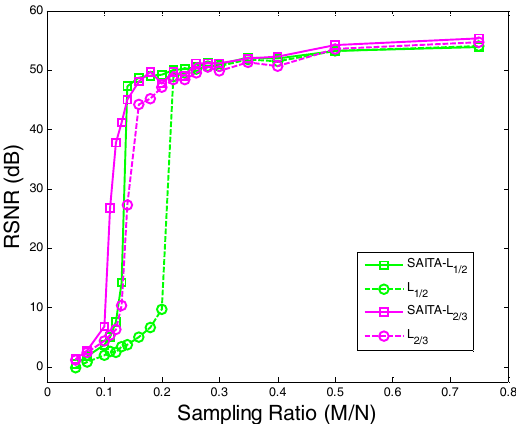
Figure 11. The RSNR of the proposed SAITA- L p ( p ∈ { 1/2, 2/3 } ) algorithm and the conventional L p ( p ∈ { 1/2, 2/3 } ) algorithm vs. the sampling ratio M / N for the mSNR = 40 dB Shepp-Logan image.